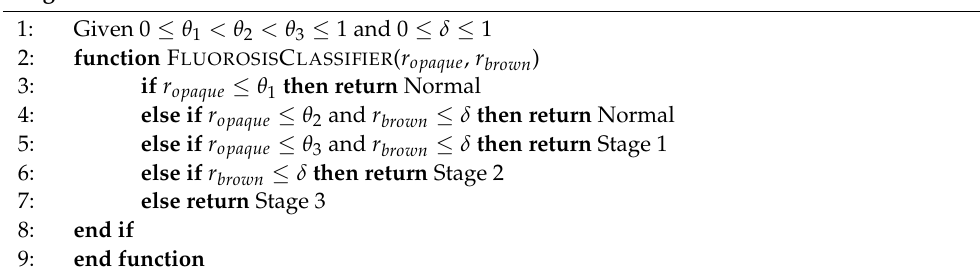
Algorithm 4. Fluorosis classification